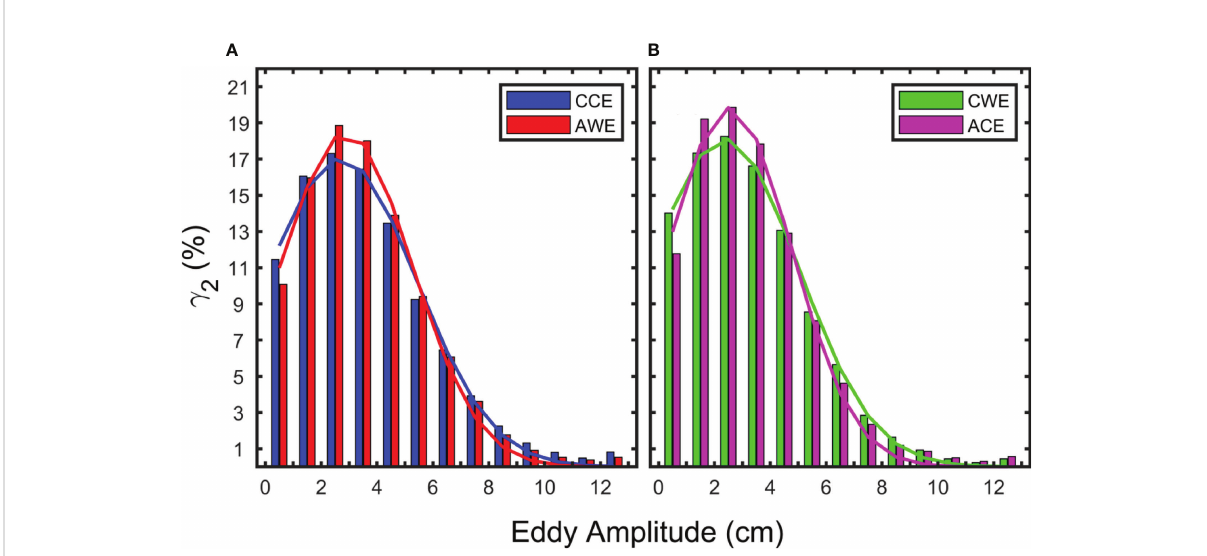
FIGURE 7 Statistical histogram of eddy amplitude for the four types of eddies. Blue, red, green, and magenta bars represent cyclonic cold-core eddy (A) , cyclonic warm-core eddy (B) , anticyclonic warm-core eddy (A) , and anticyclonic cold-core eddy (B) , respectively. The curves in the fi gure show the distribution of the Gaussian fi tting